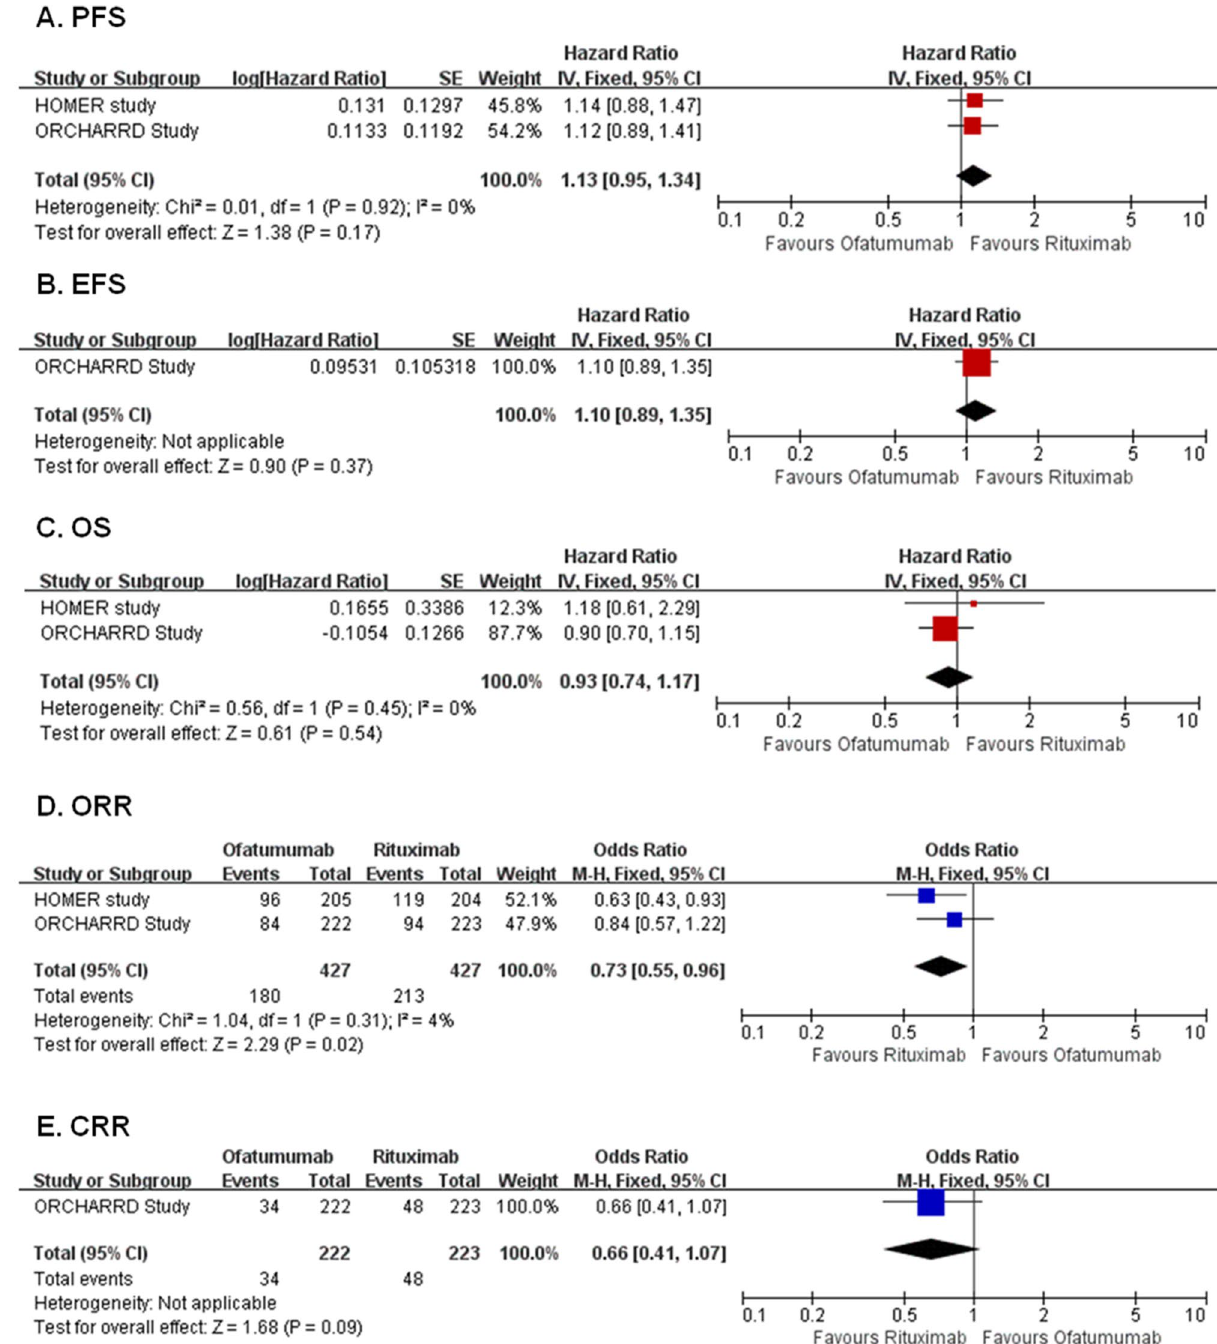
Figure 3. Forest plots of ofatumumab versus rituximab. Forest plot of the meta-analysis that estimating the ORs and HRs with their corresponding 95% CIs for the ofatumumab group, compared with that in the rituximab group. PFS progression-free survival, EFS event-free survival, OS overall survival, ORR overall response rate, CRR complete response rate, HRs hazard ratios, ORs odds ratios, 95% CI 95% confidence OS, the pooled ORs were 0.79 (95% CI 0.21–2.97, P = 0.72) for ORR and 1.17 (95% CI 0.83–1.67, P = 0.37) for CRR, which were all similar with the main analyses. 90 Y‑ibritumomab tiuxetan versus Rituximab. Two RCTs with 173 patients compared 90 Y-ibritumomab tiuxetan with rituximab in induction therapy of B-NHL. Survival outcomes including PFS (HR 0.79, 95% CI 0.54–1.18, P = 0.25), OS (HR 1.31, 95% CI 0.51–3.36, P = 0.57), and DFS (HR 1.32, 95% CI 0.30–5.87, P = 0.71) were comparable between ibritumomab arm and rituximab arm (Fig. 5A–C). A higher ORR of 90 Y-ibritumomab tiuxetan compared with rituximab was noted, with an estimate OR of 3.07 (95% CI 1.47–6.43, P = 0.003)